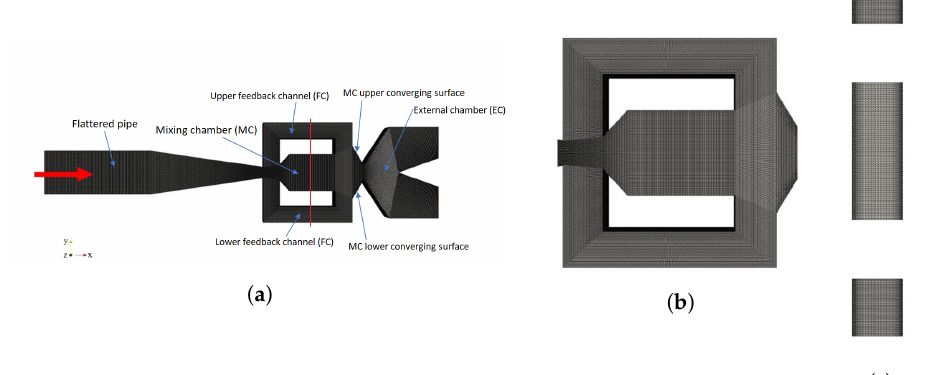
Figure 2. Grid used in the present study, ( a ) plane view, ( b ) zoom view, ( c ) side view of the mesh at the center of the mixing chamber, see the vertical